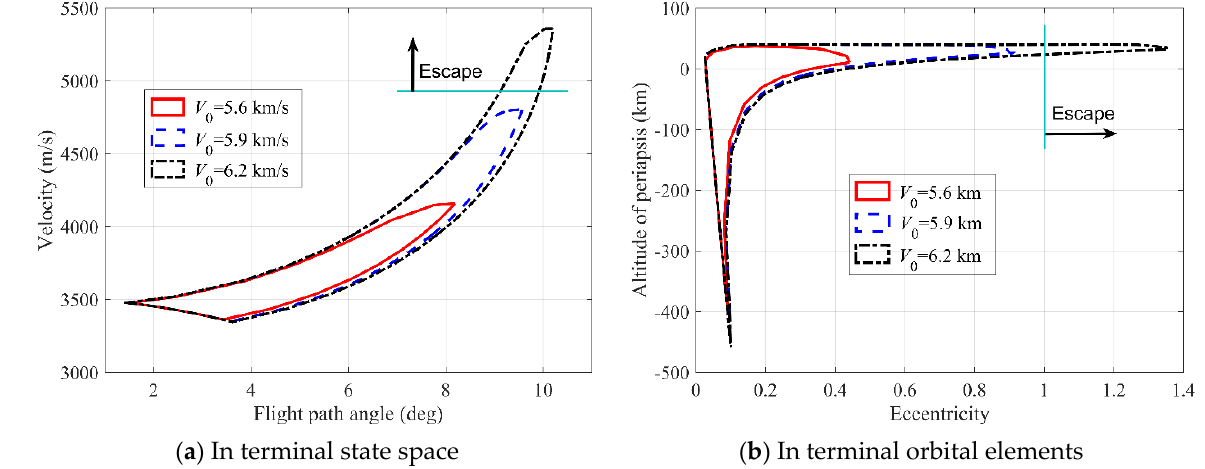
Figure 9. Aerocapture attainability sets with different initial velocities.